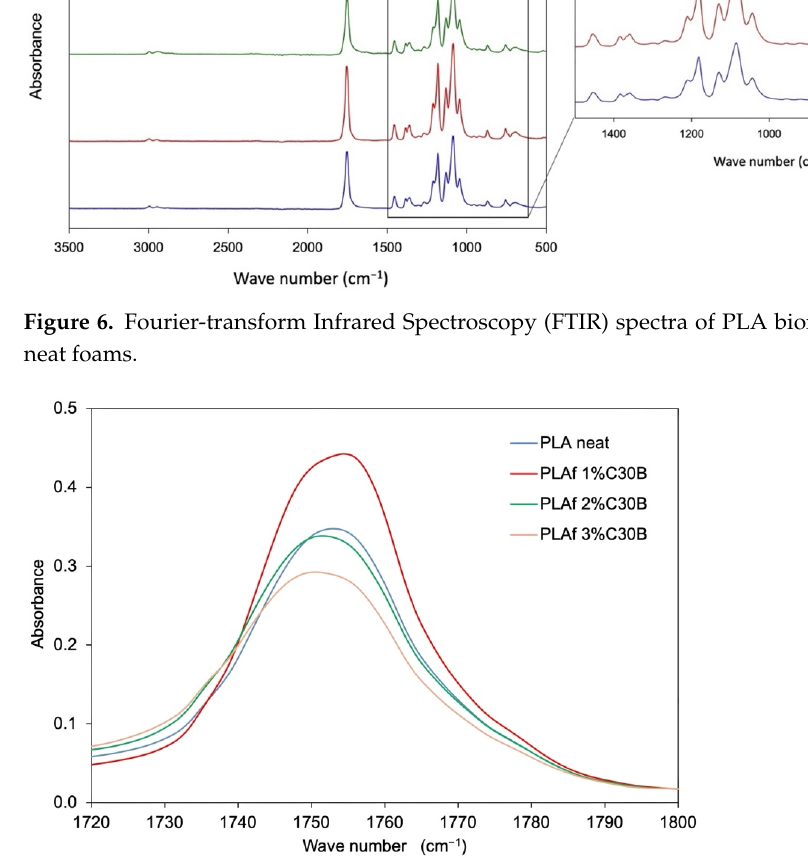
Figure 7. Fourier-transform Infrared Spectroscopy (FTIR) spectra between 1720 cm − 1 and 1800 cm − 1 of PLA bionanocomposite foams and neat PLA. of PLA bionanocomposite foams and neat